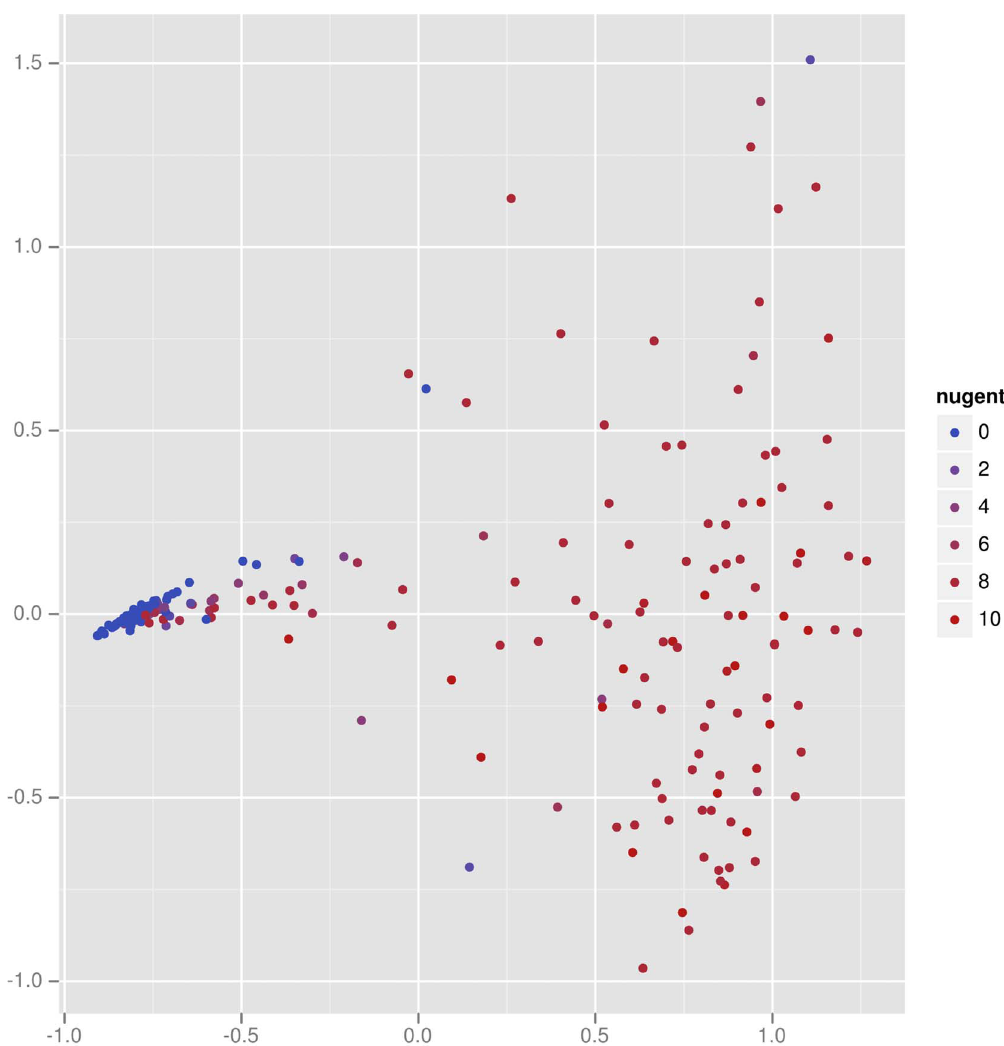
Figure 7. Principal coordinates analysis applied to the Fredricks vaginal data set.